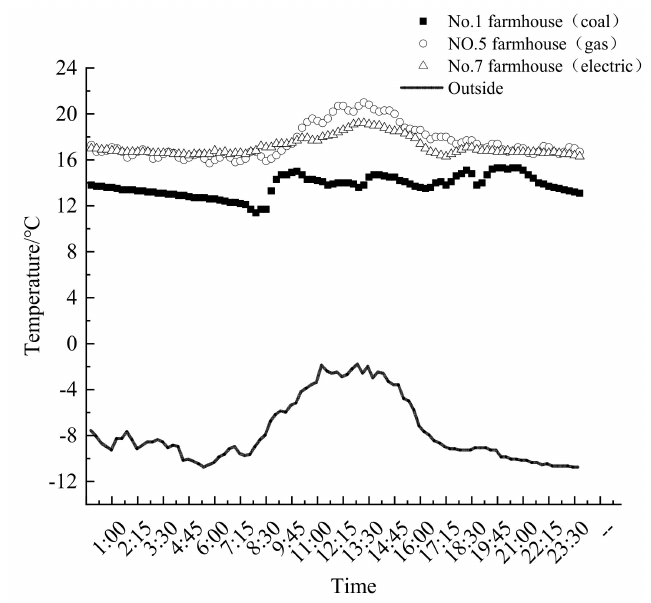
Figure 2. Indoor temperature changes of the three